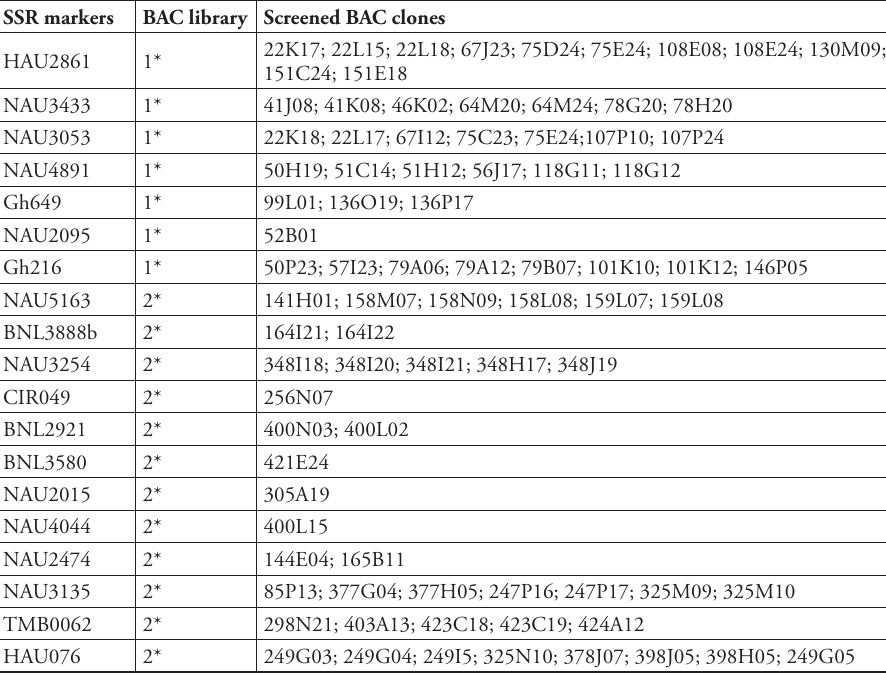
Table 2. BAC clones screened from two BAC